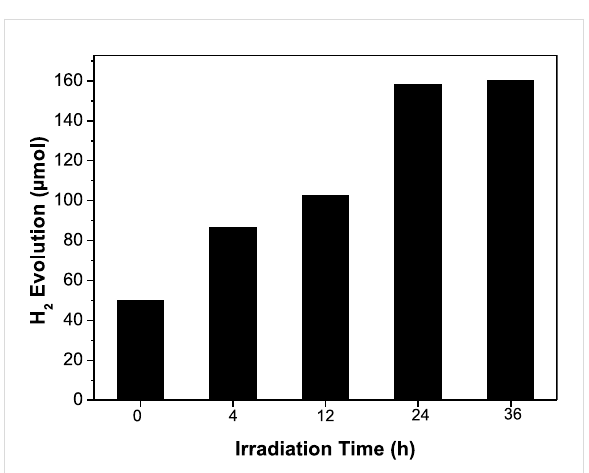
activity is 50.1 μ mol. When RGO24 is added, the H 2 evolution reaches 156.8 μ mol. The activity increases by a factor of 3.1